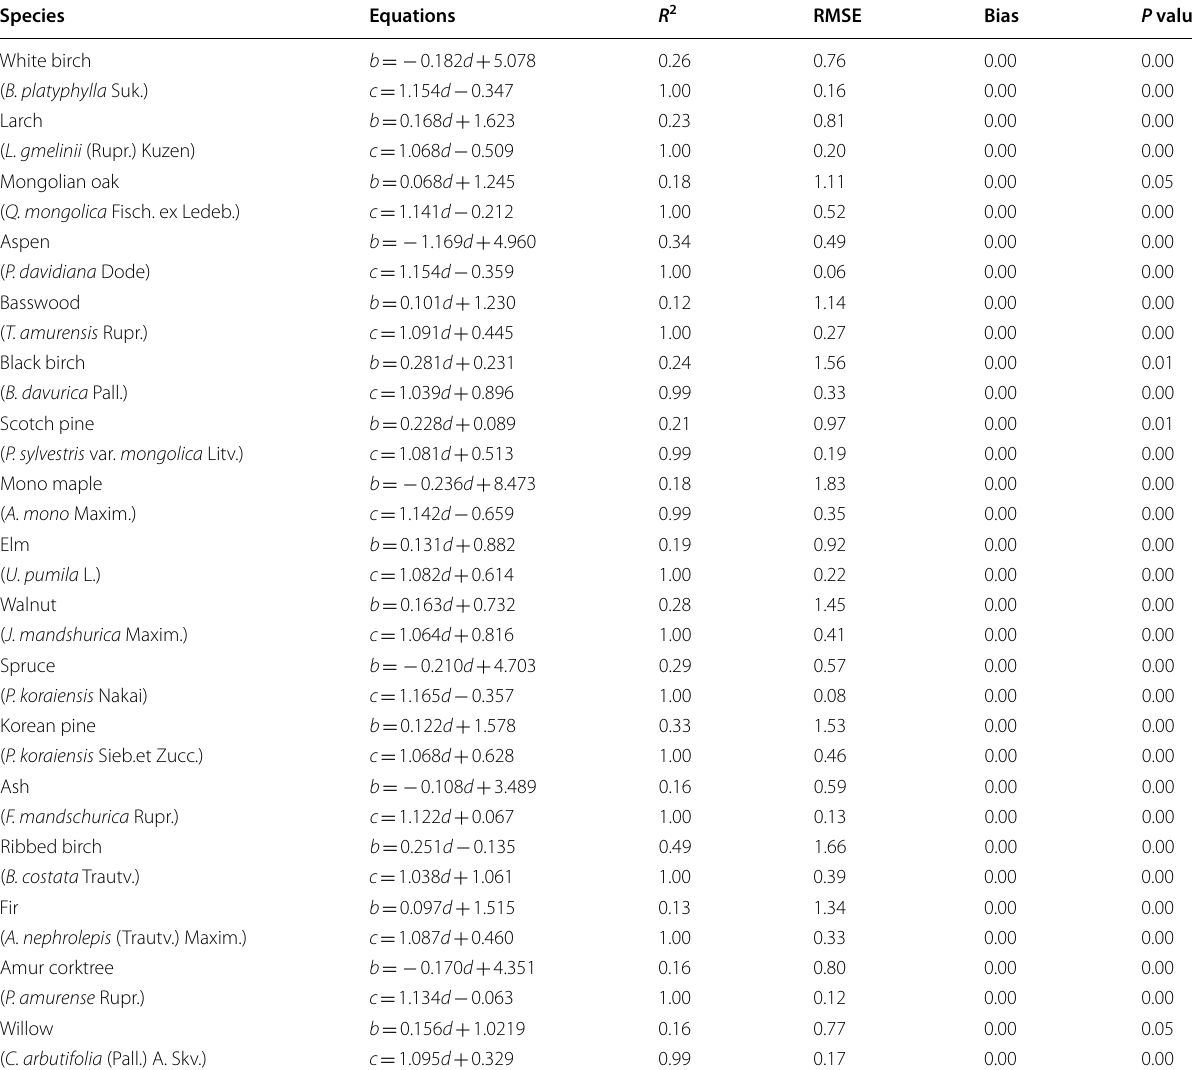
Table 3 Equations of shape parameter ( b ) and scale parameter ( c ) of Weibull distribution based on arithmetic mean DBH ( d , unit: cm) for 17 tree species and accuracy assessment using LOOCV